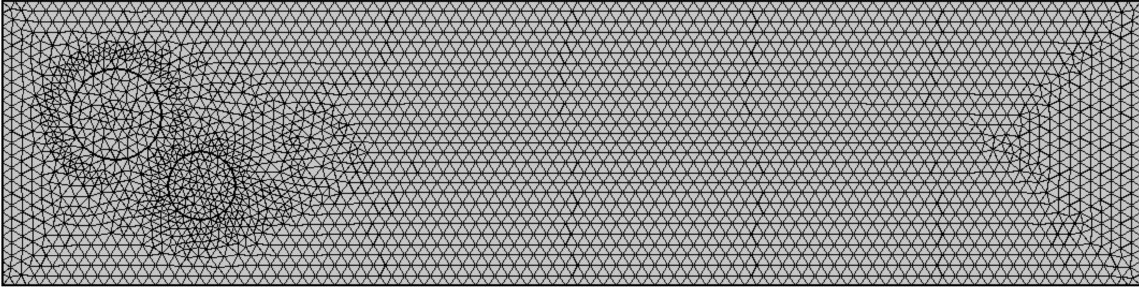
Figure 5. Mesh-generation